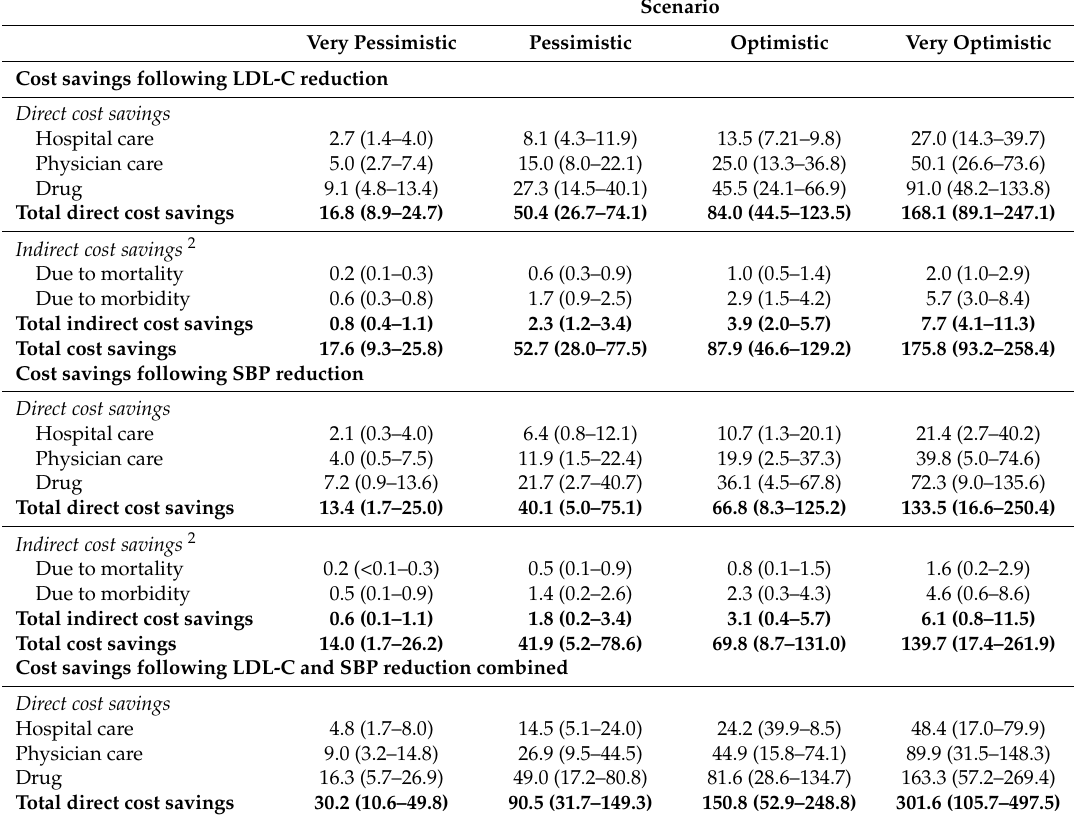
Table 6. Potential annual savings in healthcare and related costs of cardiovascular disease among Canadian adults from 100 g/day dietary pulse intake (Can$ million) 1